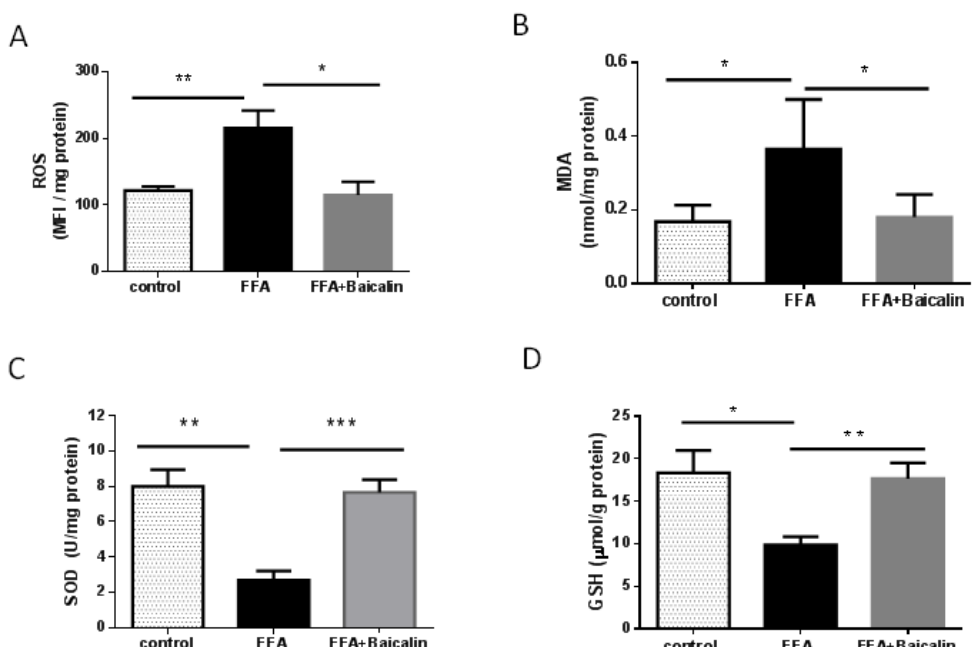
Figure 3. Regulatory effect of baicalin on the balance between oxidation and antioxidation. ( A ) ROS contents in each group. Data were presented as mean fluorescence intensity (MFI) per mg protein ( n = 5). ( B ) MDA levels in each group ( n = 6). ( C ) SOD amounts in each group ( n = 5). ( D ) GSH levels in each group ( n = 5). * p < 0.05; ** p < 0.01; *** p < 0.001.